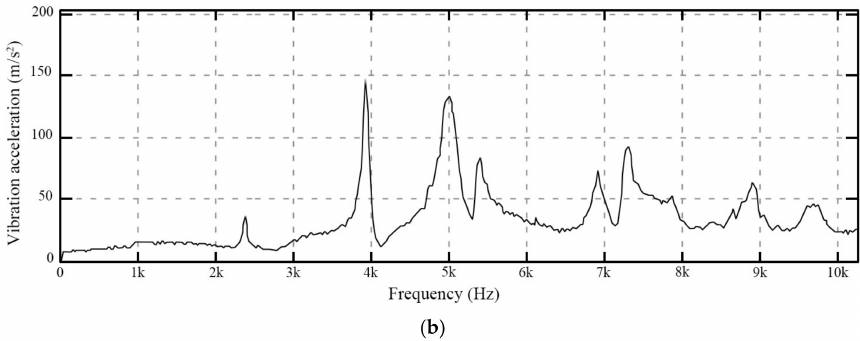
Figure 8. Cavitation sonic vibration in the time and frequency domain; pump pressure 15 MPa, confining pressure 0.5 MPa. ( a ) Time domain waveform of the vibration acceleration; ( b ) Vibration power spectrum.